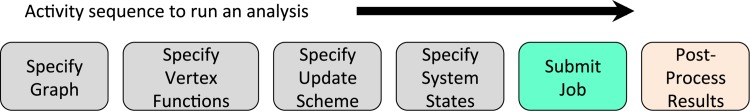
Sequence of high-level user activities to run an analysis in GDSC.